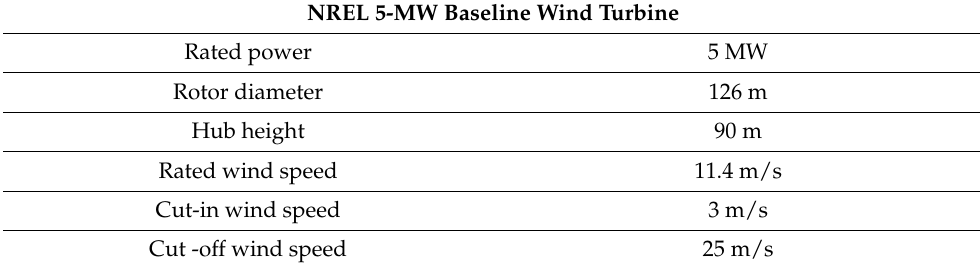
Table 1. Turbine characteristics [2].